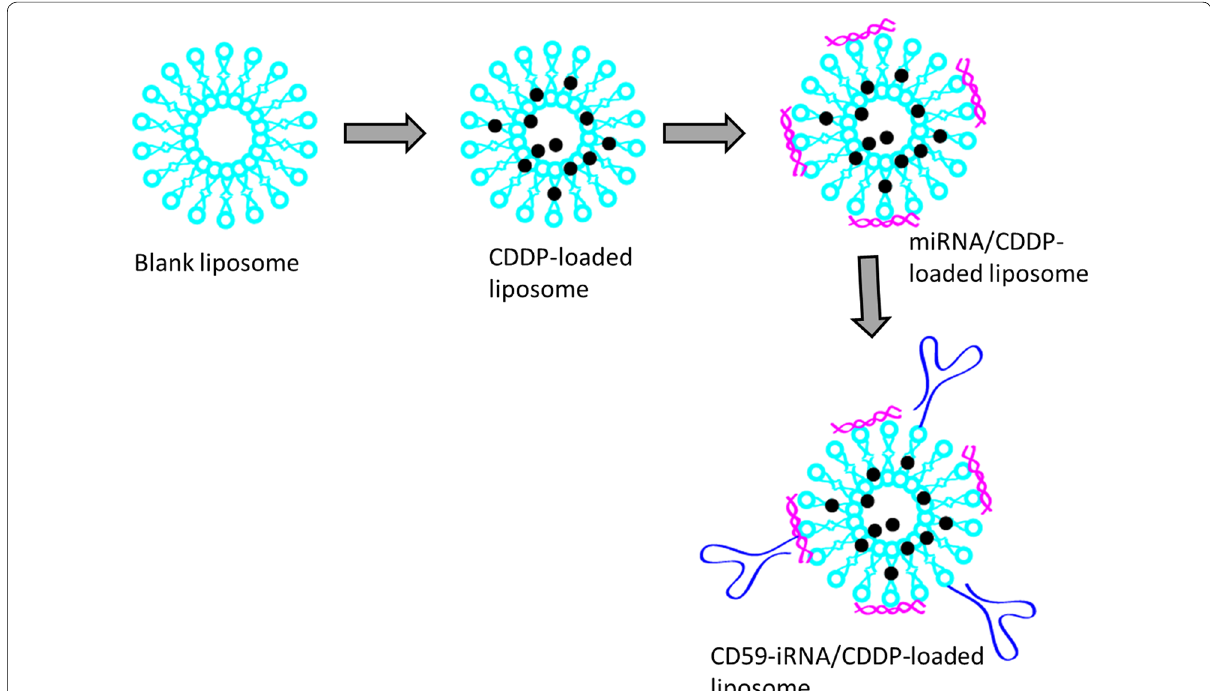
Fig. 1 Graphical presentation of preparation of CD59sp‑conjugated CDDP/miRNA‑1284 liposome. The CDDP was loaded in the liposome shell and miRNA was loaded on the surface of